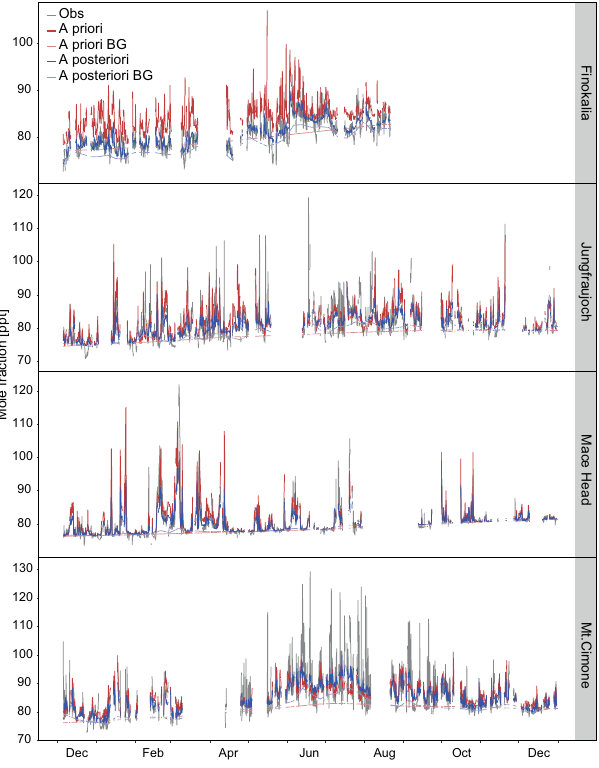
Figure 4. HFC-134a time series of the BASE inversion for 2013, showing the observed mole fractions at the respective sites (grey) and the simulated values (a priori: red; a posteriori: blue) and their baseline conditions (a priori: light red; a posteriori: light blue).